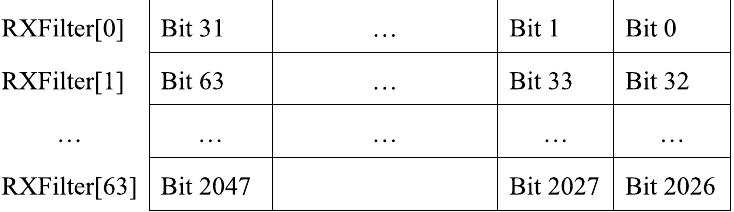
Figure 6. Structure of CAN RX message filter object.